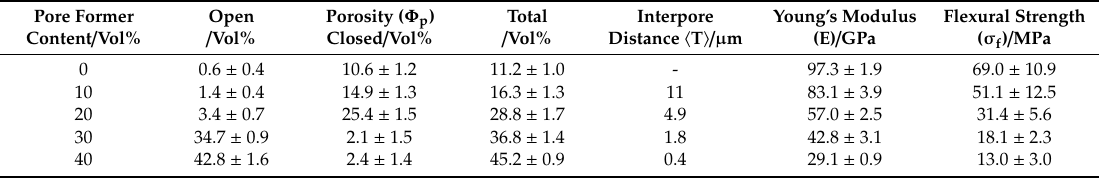
Table 1. Physical properties of the porous HAp ceramics containing 0–40 Vol% of 20 µ m spherical pore